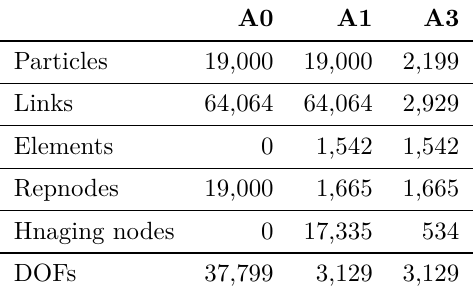
Table 1. Numbers of particles, links, elements, repn- odes, hanging nodes and unknown DOFs for exact approach (A0), QC approaches with interpolation only (A1) and QC approach with local anisotropic homogenization